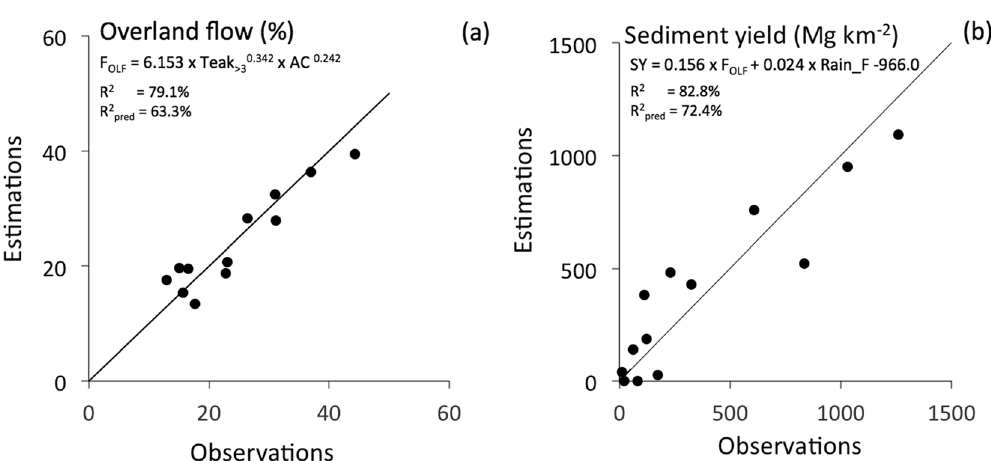
Figure 4. Statistical relationships (data collected at the S4 monitoring station) between: ( a ) median overland flow contribution to stream flow during storm events (F OLF , %) and the two explanatory variables: areal percentage of teak monocultures during year n -1 (Teak > 3 , %) and areal percentage of annual crops cultivated alone or in combination with one-or-two-years-old teak trees (AC, %); ( b ) median sediment yield (SY, Mg km − 2 ) and the two explaining variables F OLF and annual flood-triggering rainfall depth (Rain_F, mm). This graph was created using Excel 14.0